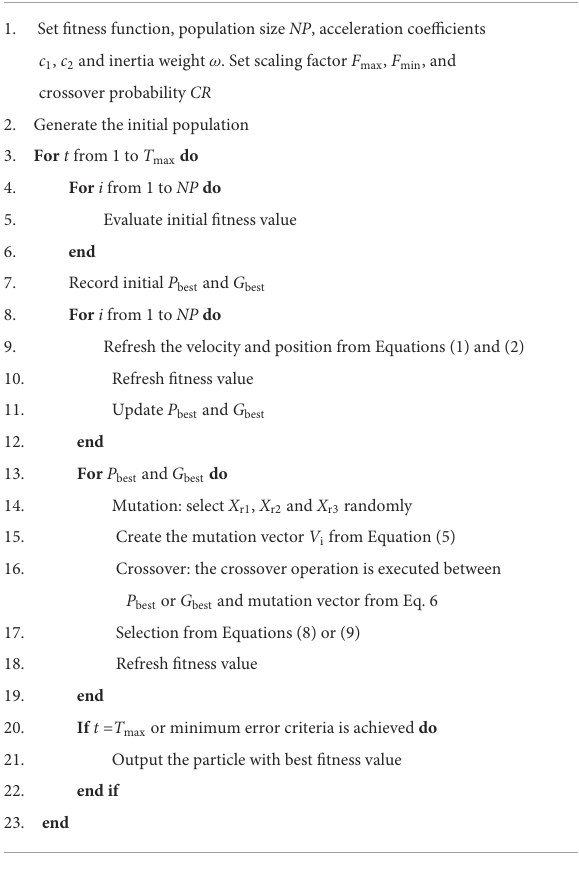
TABLE 4 Experimental hardware and software environment.